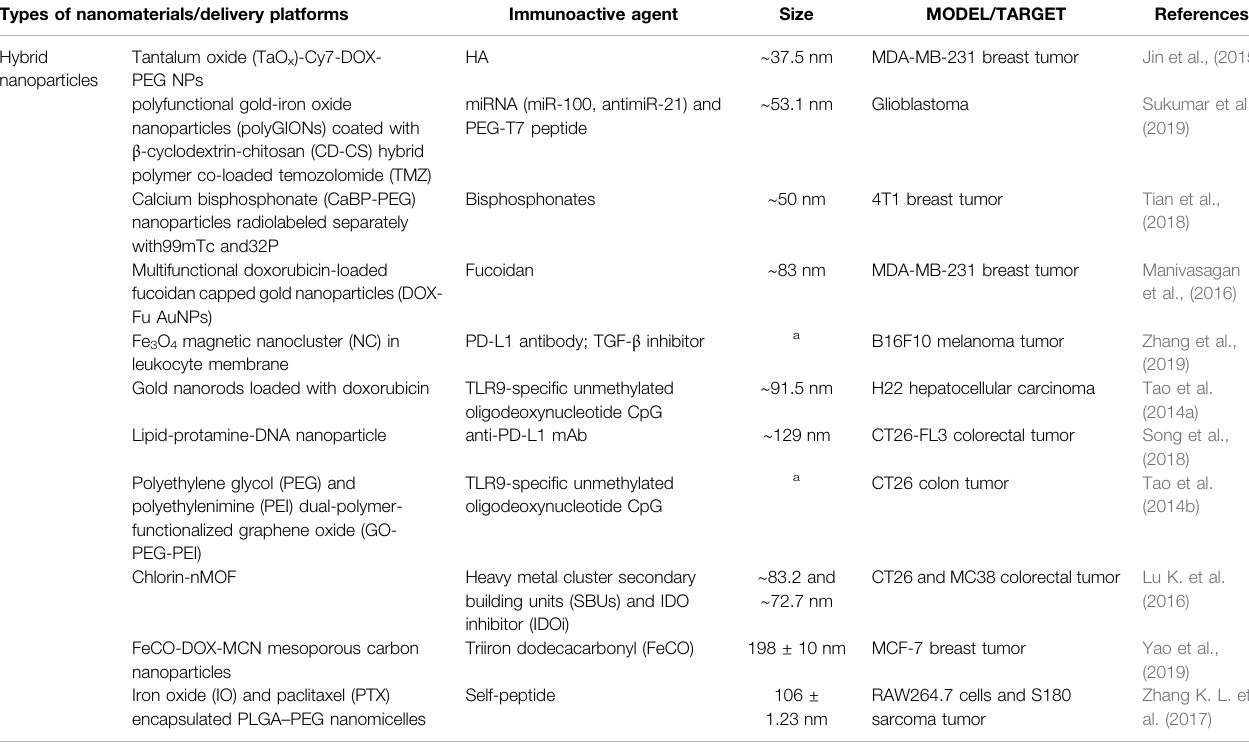
Table 1 enlists examples of theranostic nanomaterial